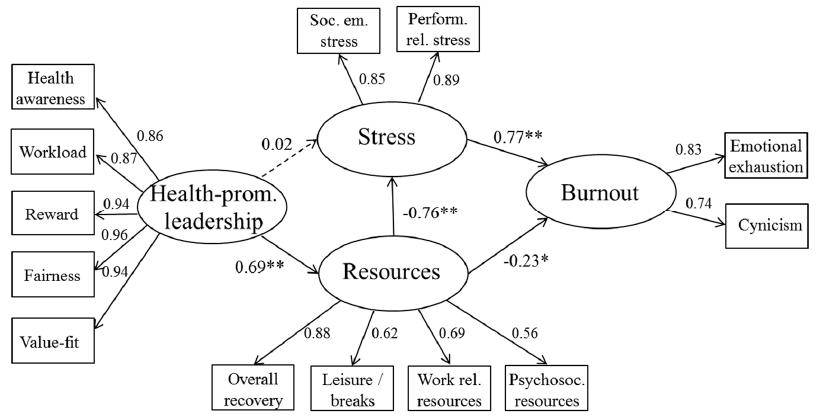
Figure 2. Structural Equation Modeling (SEM)—sample 1. ** paths are significant at p < 0.001; * paths are significant at p < 0.05. Table 2. Direct impacts in the structural model—sample 1.